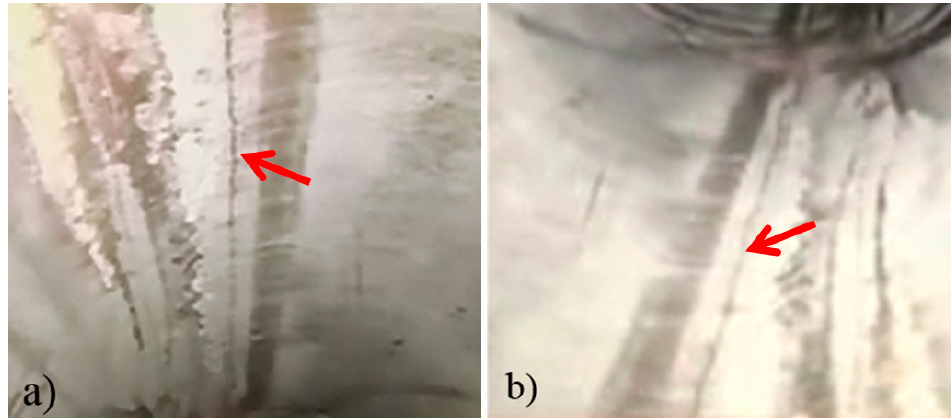
Figure 3. Longitudinal cracks: ( a ) at the crown; and ( b ) at the invert.